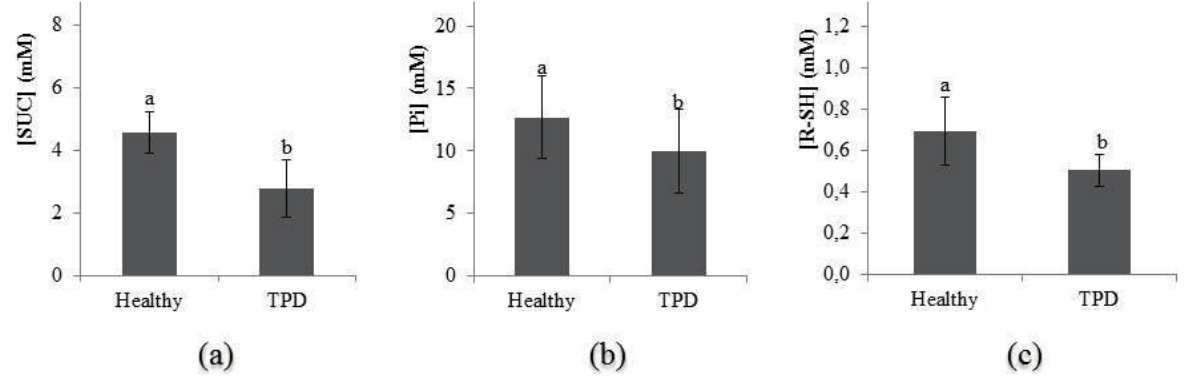
Figure 6. Sucrose (SUC; a ), inorganic phosphorus (Pi; b ) and thiol (R-SH; c ) contents in latex of healthy and TPD-affected plants for clone PB 260. The Fisher’s F -test was used